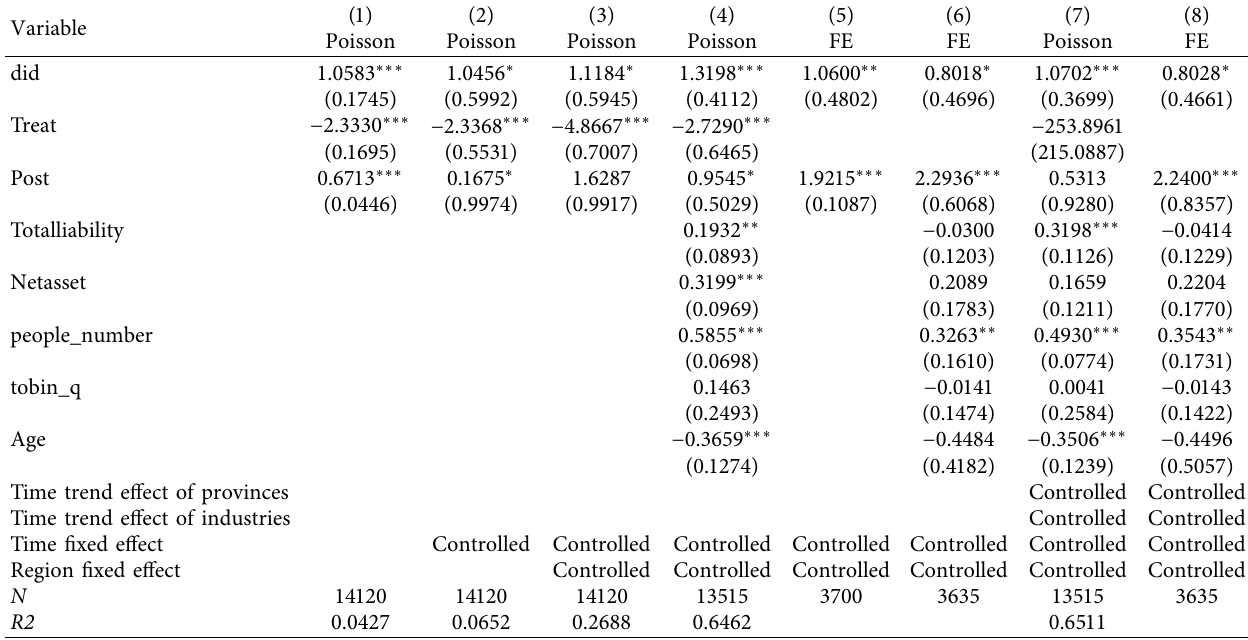
Table 2: Baseline regression.